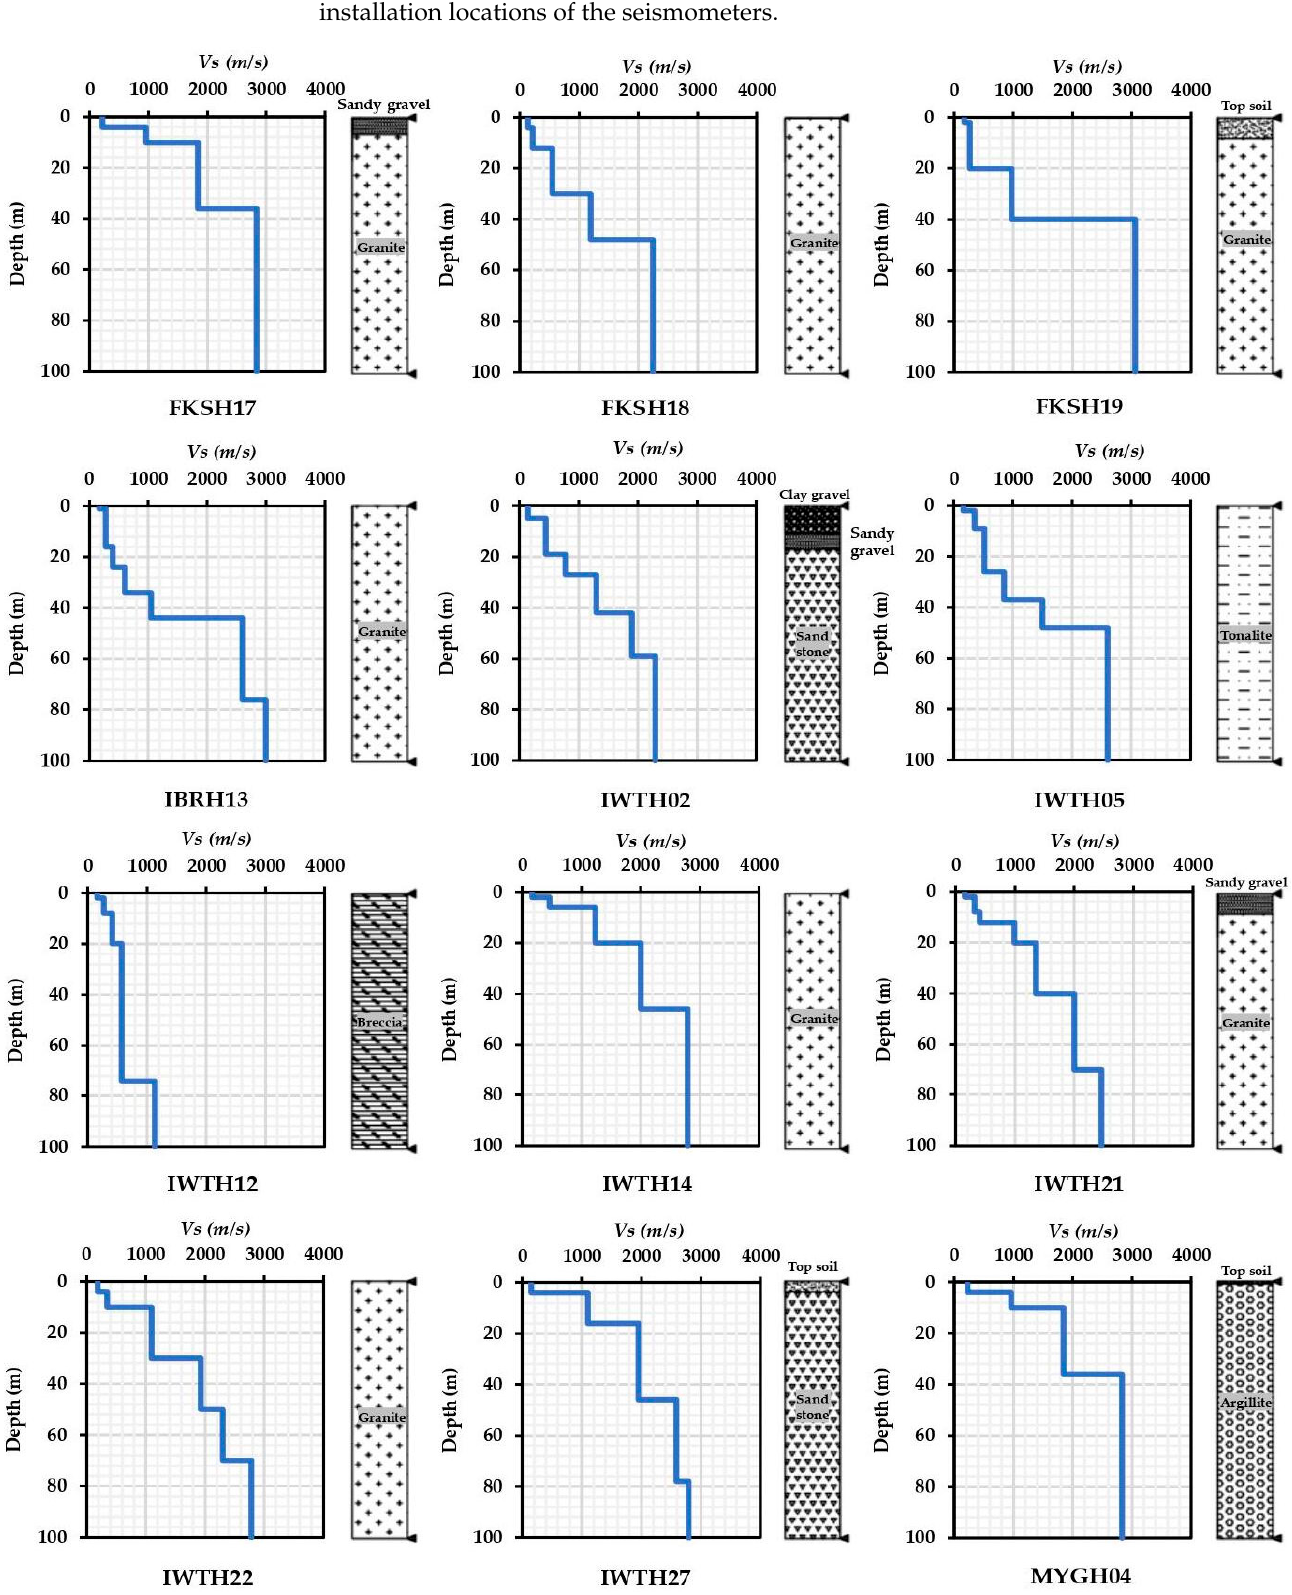
Figure 2. Soil profiles and shear wave velocities at the selected sites.